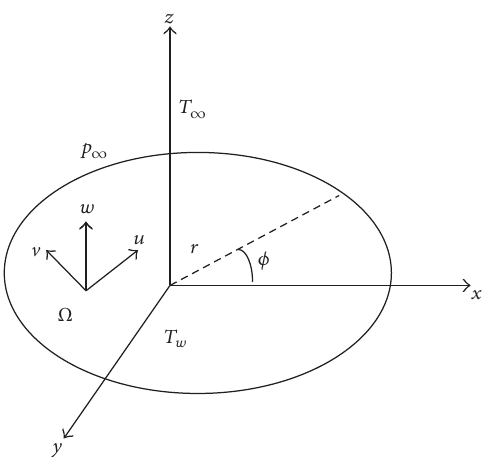
Figure 1: Coordinate system for the rotating disk